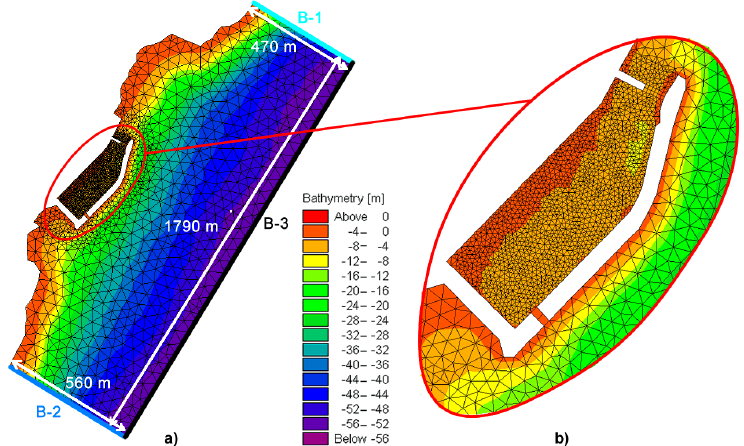
Figure 8. ( a ) Computational domain used for simulations (discretization with triangular cells); ( b ) a close-up view of the marina domain.